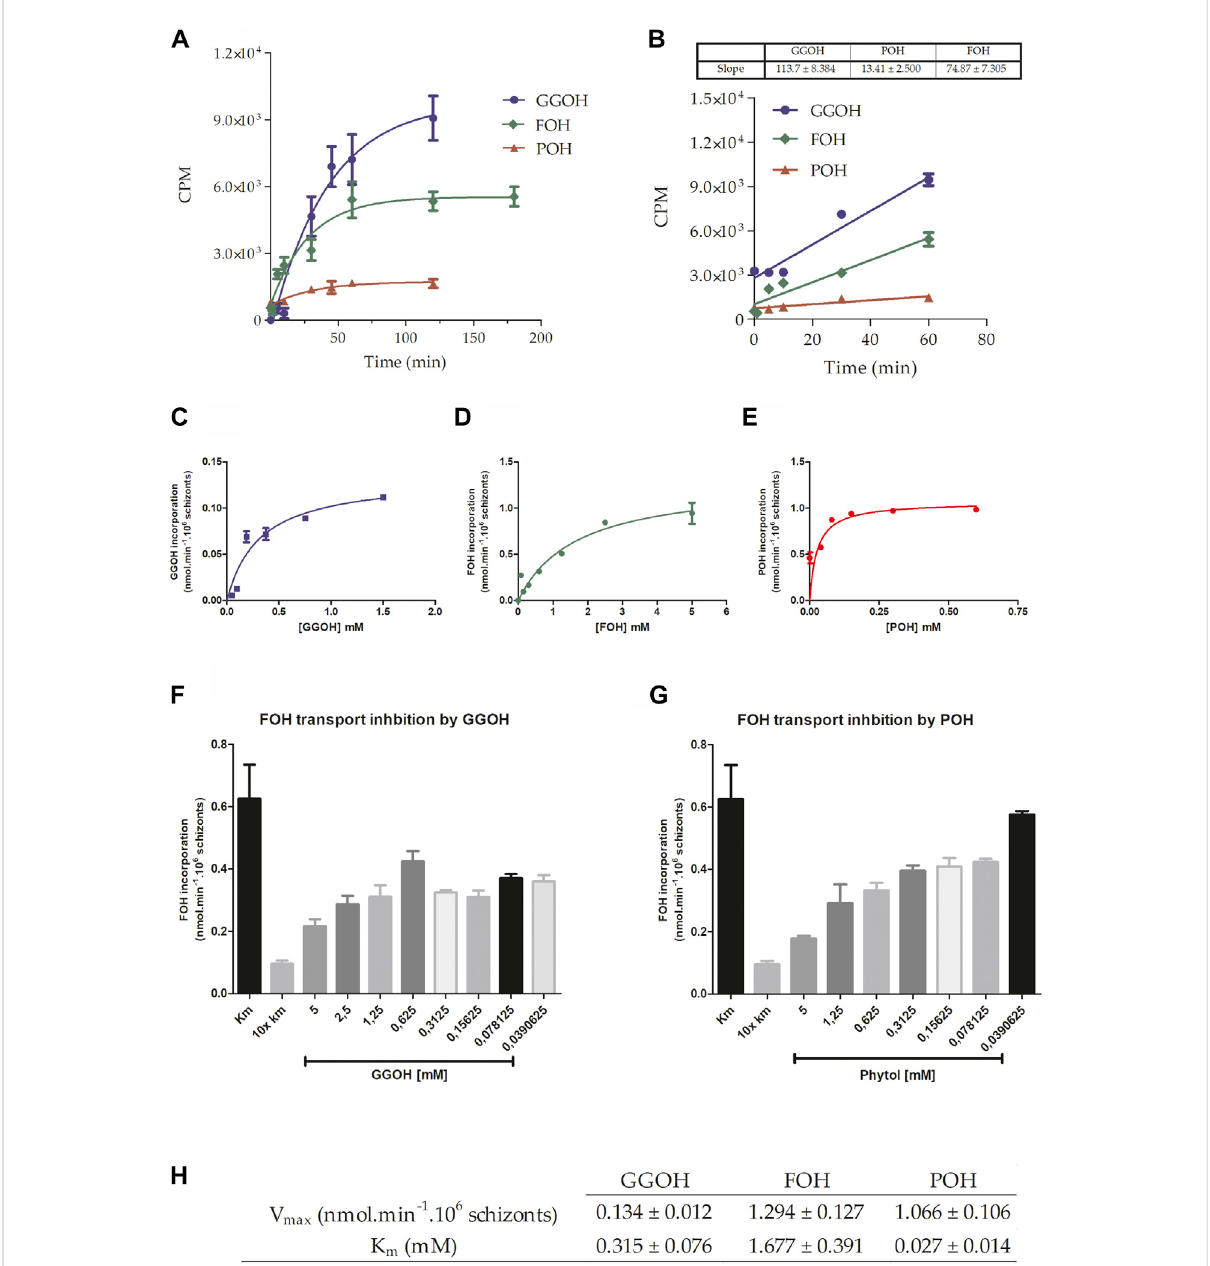
FIGURE 2 Characterization of isoprenoid alcohols ’ transport. (A) The incorporation of 0.5 mM of GGOH or POH and 1 mM of FOH traced with the respective radiolabelled molecules was measured for 120 min. In (B) , the slope of the transport process up to 60 min was estimated using a linear regression equation. With this data, it was possible to calculate de V 0 (initial velocity), fundamental to verify the effect of the concentration on the transport of (C) GGOH, (D) FOH, and (E) POH. After that, the transport of FOH (at the concentration corresponding to K m : 1.7 mM) was measured in the presence of different concentrations of (F) GGOH or (G) POH, presenting a concentration-dependent inhibition pro fi le. An inhibition control was used as an excess of non-radioactive FOH. In the end, the kinetic parameters were summarized in (H)